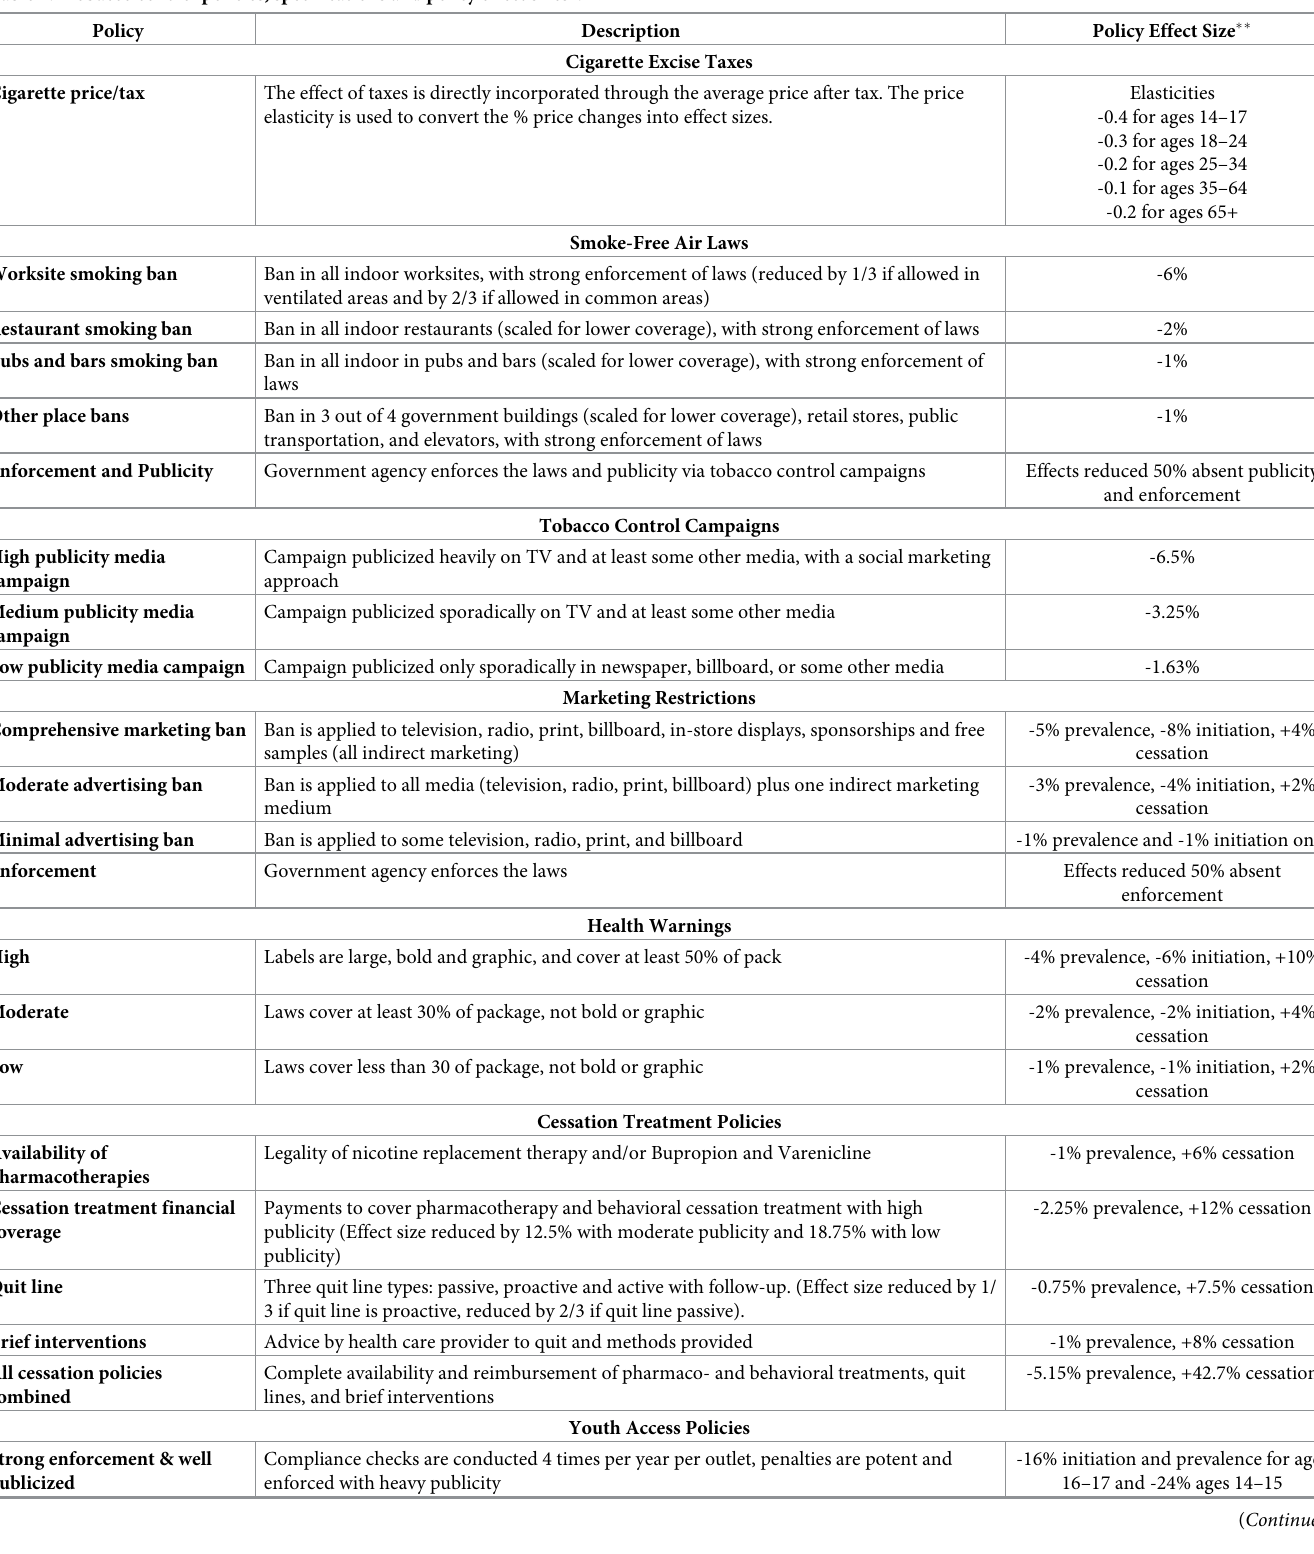
Table 1. Tobacco control policies, specifications and policy effect sizes �